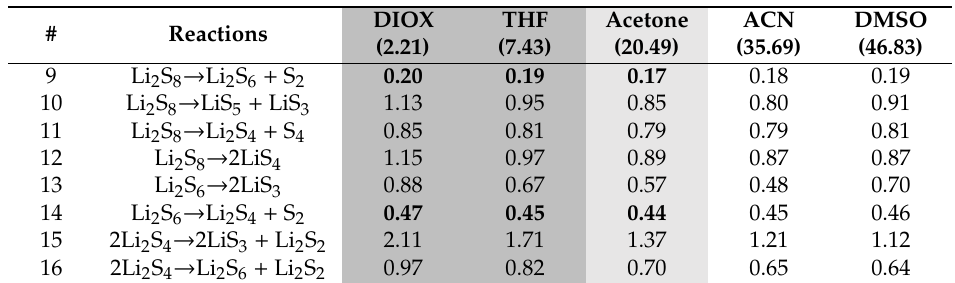
Table 2. The reaction free energies ( ∆ G, eV) of lithium polysulfides in di ff erent solvents. The dielectric constants ( ε ) of di ff erent solvents are presented in parentheses. The solvents that tend to facilitate the reactions of the bound LiPS’s are shaded in grey, and the reaction energies for the more probable reactions are in